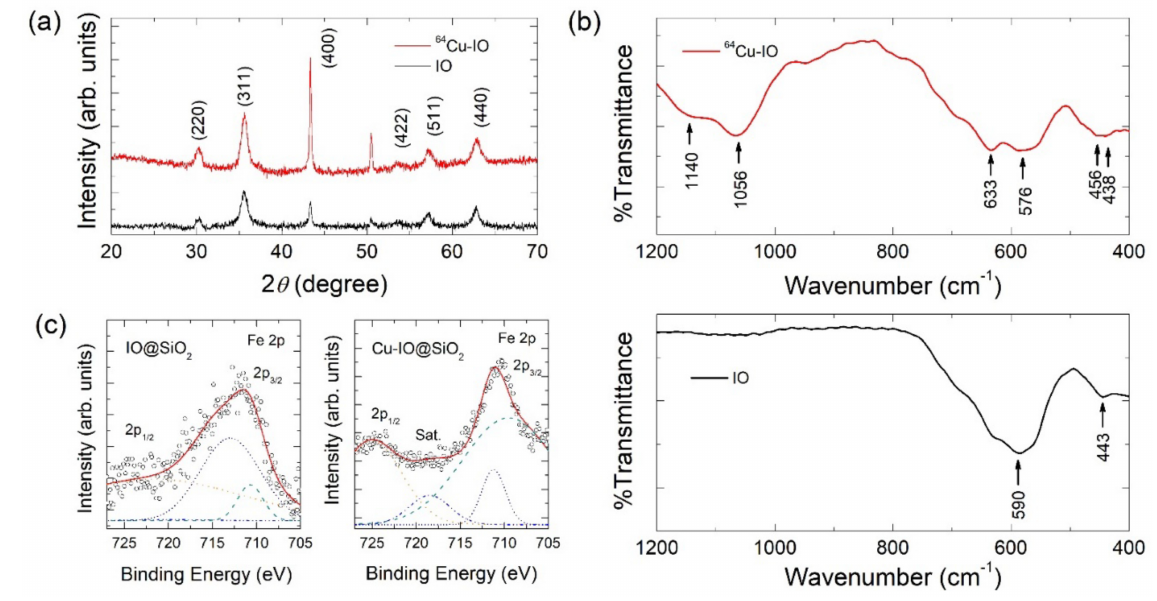
Figure 2. ( a ) XRD patterns and ( b ) FTIR spectra for chelator-free 64 Cu-IO (upper panel) and IO NPs (lower panel). ( c ) XPS spectra of IO@SiO 2 (left) and Cu-IO@SiO 2 (right) for Fe 2p.